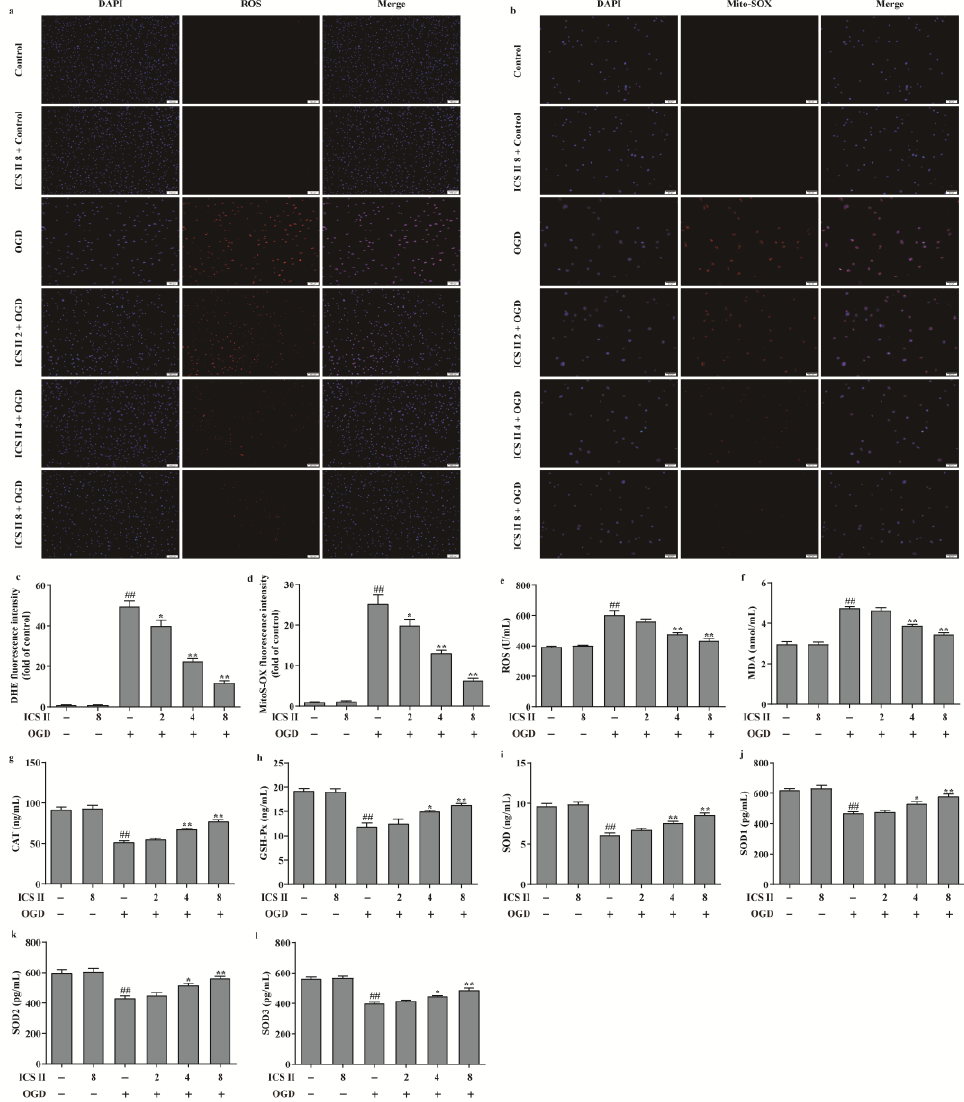
Figure 6. ICS II suppressed OGD-induced intracellular and mitochondrial oxidative stress: ( a ) DHE staining. Magnification × 100; scale bar, 100 μm; ( b ) Mito-SOX staining. Magnification × 100; scale bar, 50 μm; ( c ) quantitative analyses of DHE fluorescence intensity ( n = 5); ( d ) quantitative analyses of Mito-SOX fluorescence intensity ( n = 5); ( e ) ROS level ( n = 6); ( f ) MDA level ( n = 6); ( g ) CAT activity ( n = 6); ( h ) GSH-Px activity ( n = 6); ( i ) SOD activity ( n = 6); ( j ) SOD1 activity ( n = 6); ( k ) SOD2 activity ( n = 6); ( l ) SOD3 activity ( n = 6). The data are presented as the mean ± SEM. ## p < 0.01 vs. control; * p < 0.05, ** p < 0.01 vs. OGD.